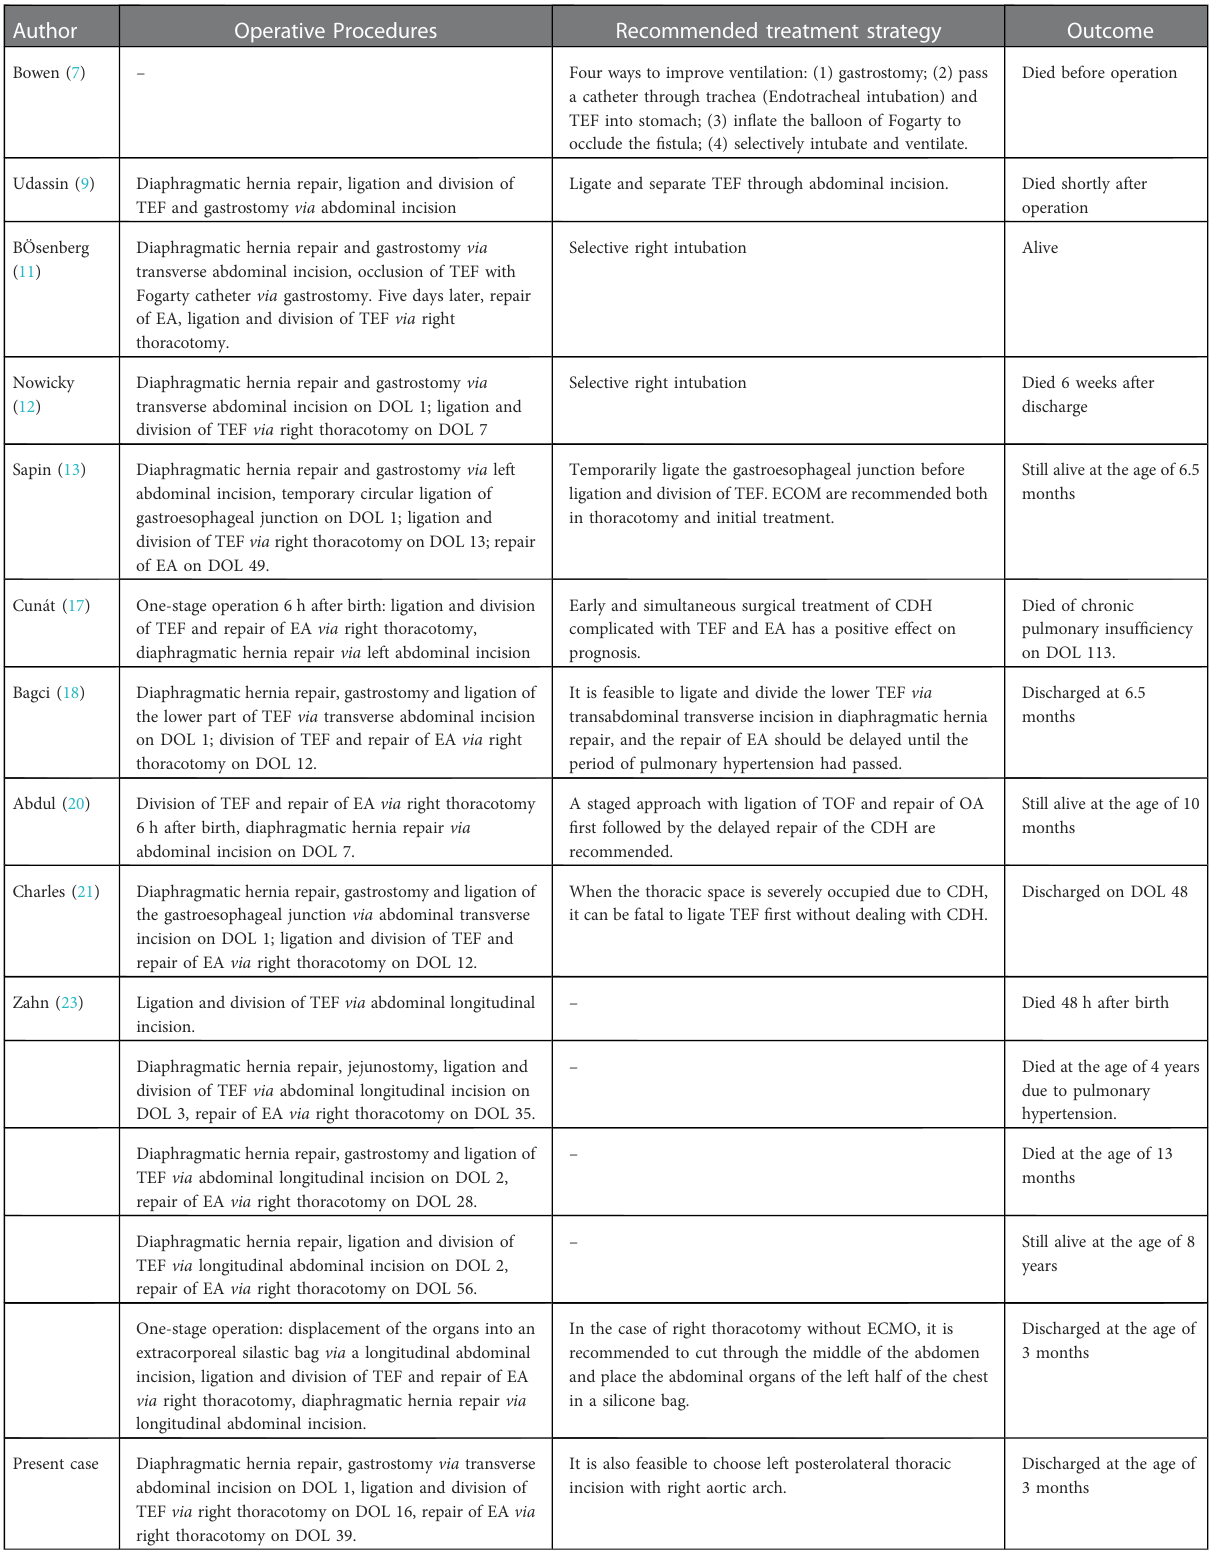
TABLE 2 Summary of treatments of left CDH associated with EA or EA and